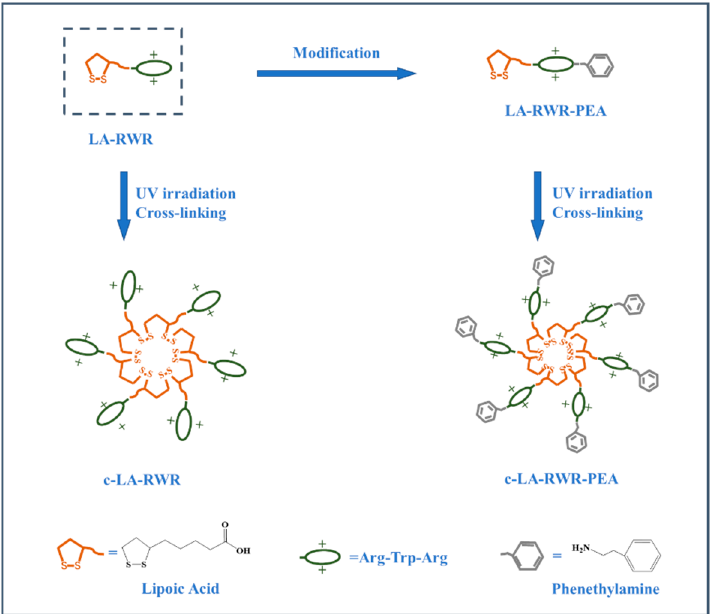
Figure 1. Schematic diagram of engineered ultra-short peptide nanoparticles with excellent antimi- crobial activity.